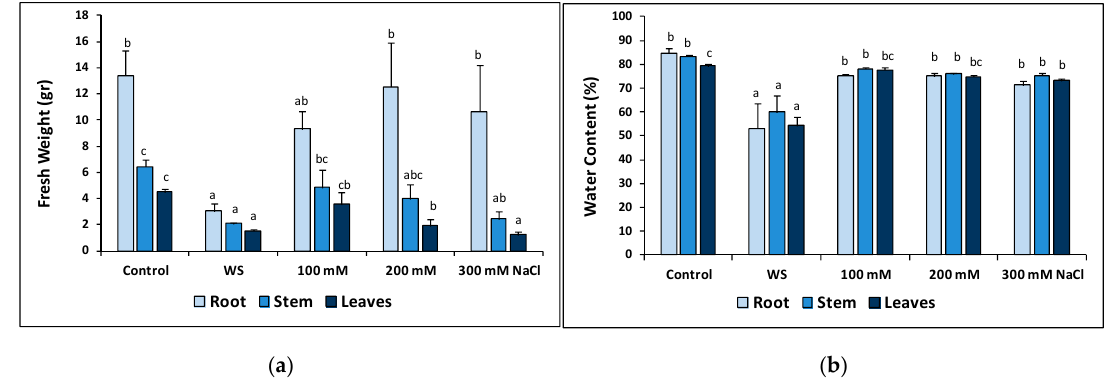
Figure 5. Fresh weight ( a ) and water content percentage ( b ) of roots, stems and leaves after 23 days of water stress (complete withholding of irrigation) and salt stress (at the indicated NaCl concentrations) treatments, in Thalictrum maritimum plants grown in controlled conditions in the greenhouse. Values shown are means ± SE ( n = 5). For each organ, roots, stems or leaves, same lowercase letters over the bars indicate homogeneous groups between treatments according to the Tukey test ( p ≤